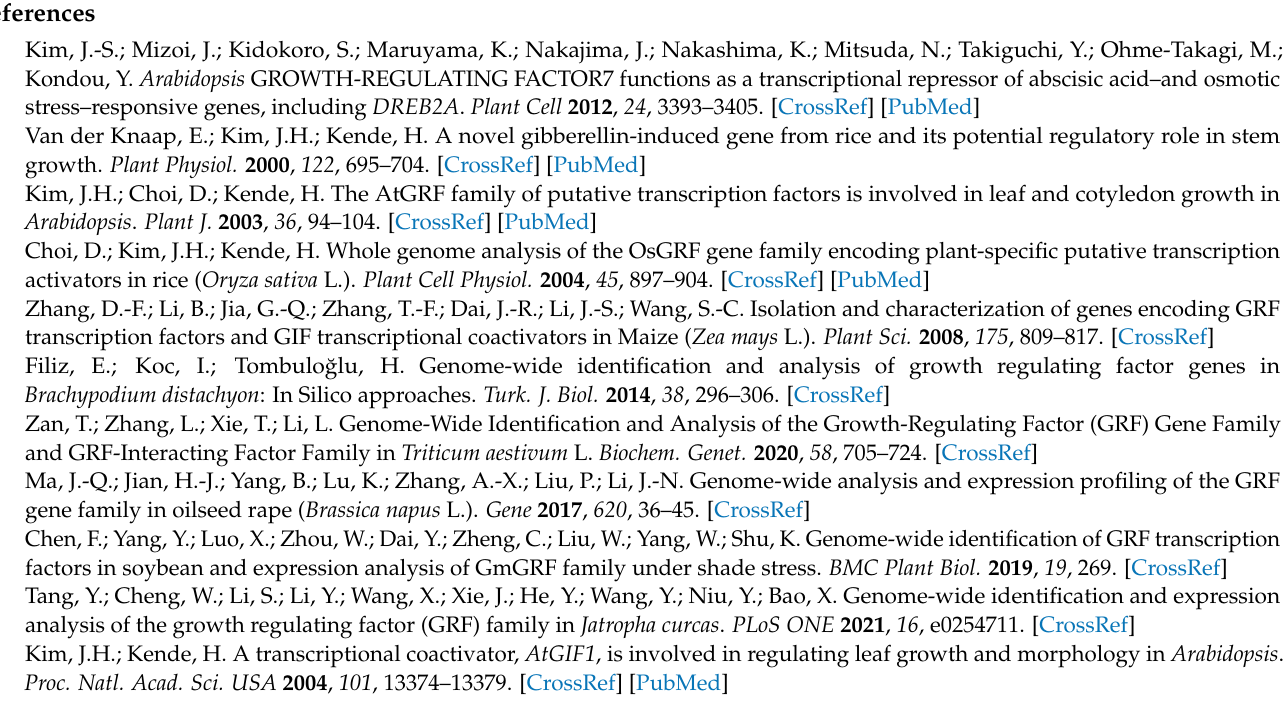
AcGRF and AeGRF proteins. Identical amino acids (aa) are indicated by colored background. The QLQ and WRC domains are presented by colored rectangle boxes. Figure S2. Number of genes on each chromosome of Ac and Ae . Figure S3. Occurrence of exons and introns in AcGRF and AeGRF genes. Figure S4. Logos for conserved motifs in AcGRF and AeGRF proteins. Figure S5. Heatmaps for different transcriptomic data of kiwifruit. (A) Heatmap showing expression profile of AcGRFs and AeGRFs in different plant tissues of Ac under Psa. invasion. (B) Heatmap representing expression profile of AcGRFs and AeGRFs in Ac and Ae under Psa. invasion. (C) Expression profile of AcGRFs in fruit samples of Ac taken at different developmental stages. Figure S6. Promoter analysis of AcGRFs and AeGRFs for cis-regulatory elements. Figure S7. Protein structure analysis for AeGRFs and AcGRFs . Table S1. Characterization of kiwifruit GRFs . Table S2. Collinearity analysis of kiwifruit GRFs . Table S3. Sequences for motifs predicted in kiwifruit GRFs . Table S4. Detail for acronyms used in cis-regulatory elements in Table 1. Table S5. List of pair of primers used in RT-qPCR